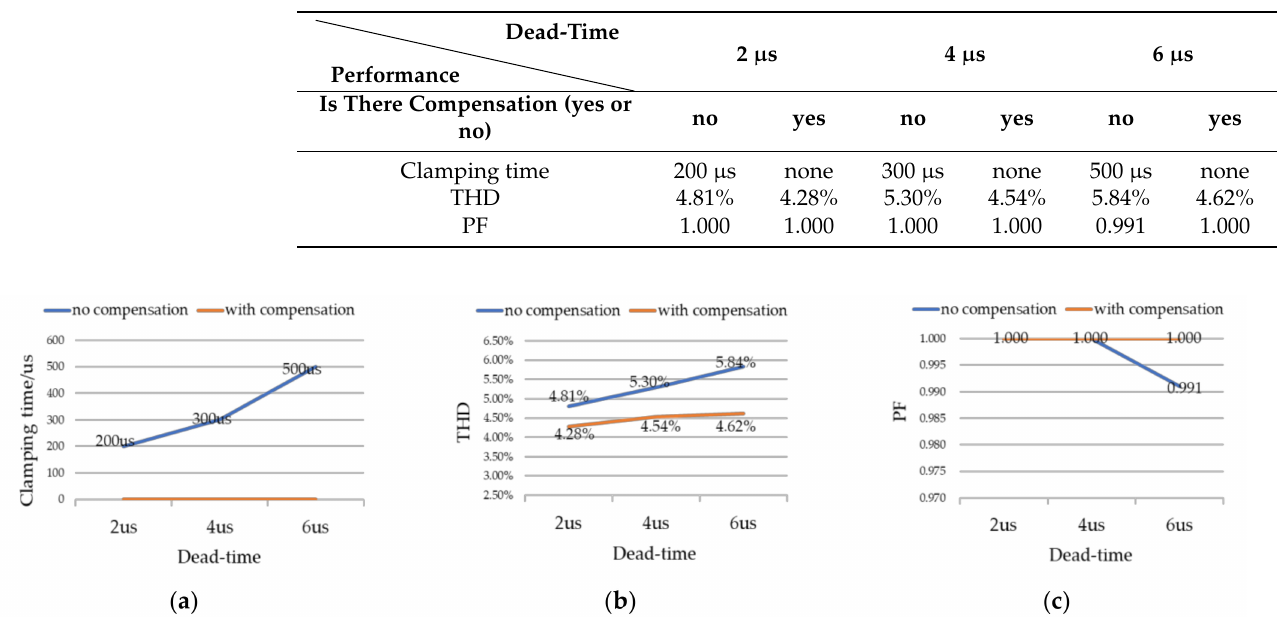
Figure 22. Graph of the relationship between dead time and: ( a ) Clamping time; ( b ) THD; ( c )